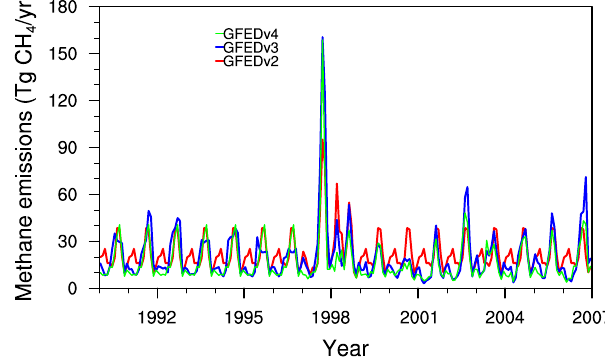
Figure 2. Comparison of the interannual variation in methane emis- sions from fire in the GFED v2 (van der Werf et al., 1996), GFED v3 (Gilglio et al., 2010), and GFED v4 (van der Werf et al., 2010). These data sets are obtained from